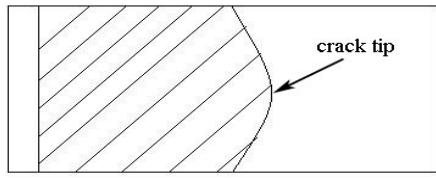
Figure 7. The schematic of ToF-SIMS analysis point.